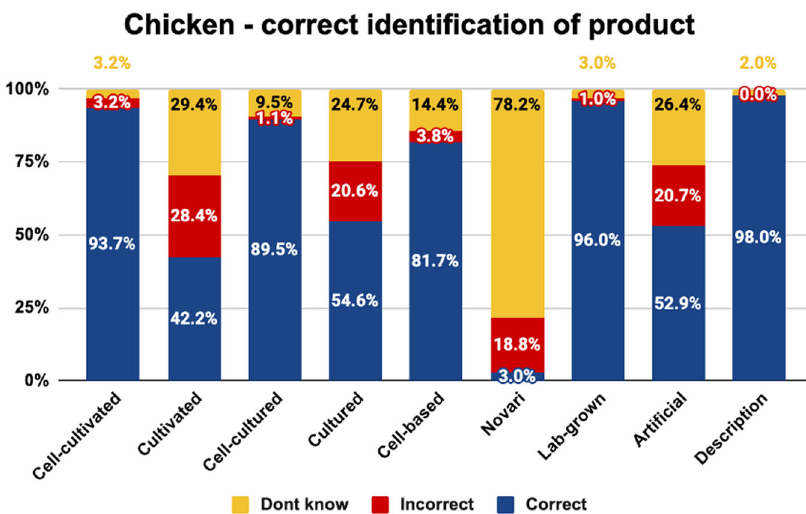
Fig. 2 Correct identi fi cation of chicken by label. The graph shows the proportion of respondents who selected the correct or incorrect cell- cultivated chicken product description, or did not know, by experimental condition.